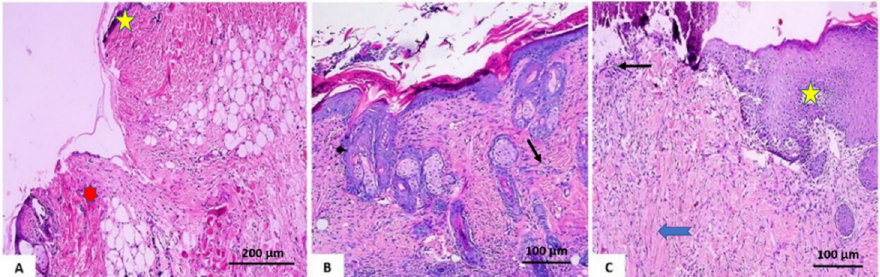
Figure 8. Skin wounds seven days post-incision. ( A ) Group 1 shows ordinary wounded edges with the ordinary epidermis (yellow star). The wound is packed with sloughed granulation tissue (represented by red asterisk) and blood clots. ( B ) Group 2 shows dermal collagen fibers compactly organized (black arrow). ( C ) Group 3 shows scar tissue blocking the wound (yellow star), collagen fibers (blue arrowhead) mirroring that of the neighboring normal dermis, as well as inflammatory cellular infiltration of macrophages (black arrows). (Hematoxylin and eosin stain 200 and 400.).